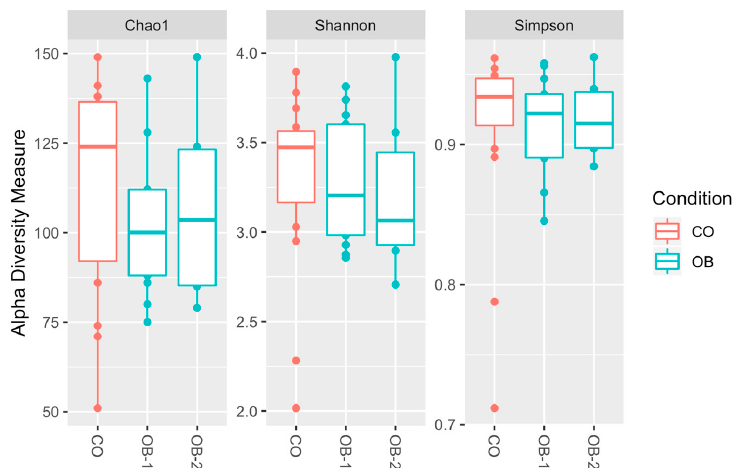
Figure 1. Alpha diversity of taxa identified in the Control (CO), Moderately Obese (OB-1) and Severely Obese (OB-2) groups. Alpha diversity analysis was performed through several metrics in order to assess the within-sample diversity and compare species richness between the different conditions under study. Chao1, Shannon entropy and Simpson diversity indices were calculated. Overall, the plots show a trend of decreased richness in OB-1 and OB-2 respect to CO, but no statistically significant differences were highlighted by performing the Wilcoxon rank-sum test (Mann-Whitney).